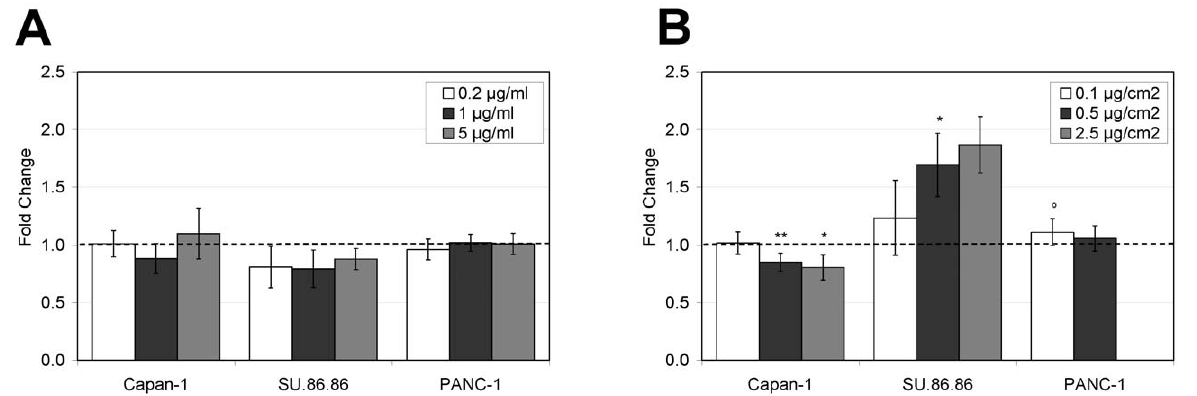
Figure 2. Effect of TNC on the migration of pancreatic cancer cell lines. (A)Cells were plated onto uncoated plates and after 24 hours the monolayer was scraped with a 10 m l pipette tip. Cells were then incubated in serum free medium or in medium with the addition of TNC at different concentrations (0.2 m g/ml, 1 m g/ml and 5 m g/ml) up to 48 hours. (B) Cells were plated onto 24-well plates coated with three different concentrations of TNC (0.1 m g/cm 2 , 0.5 m g/cm 2 and 2.5 m g/cm 2 ) or onto uncoated plates and after 24 hours the monolayer was scraped with a 10 m l pipette tip. Cells were then incubated in serum free medium up to 48 hours. Migration of cells into wounded areas was evaluated counting migrated cells manually and by the TScratch software [36] and a total of 2–8 fields were counted per group in each experiment. Data are calculated as mean + / 2 s.e.m. and expressed as fold-change compared to the non treated cells ( u p , 0.05, *p , 0.01, **p , 0.001, Students two-tailed t test).